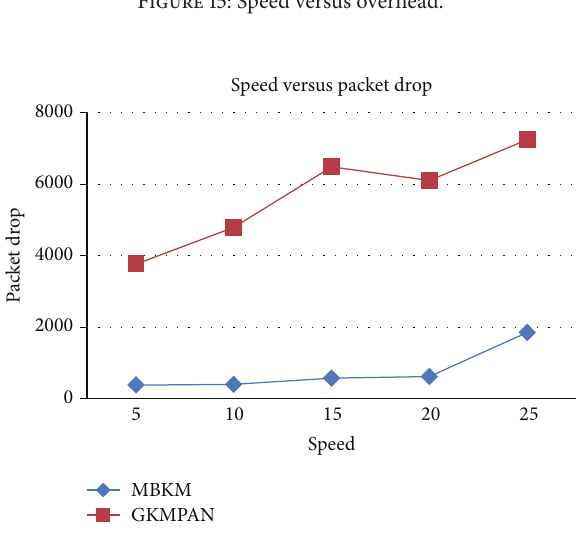
Figure 16: Speed versus